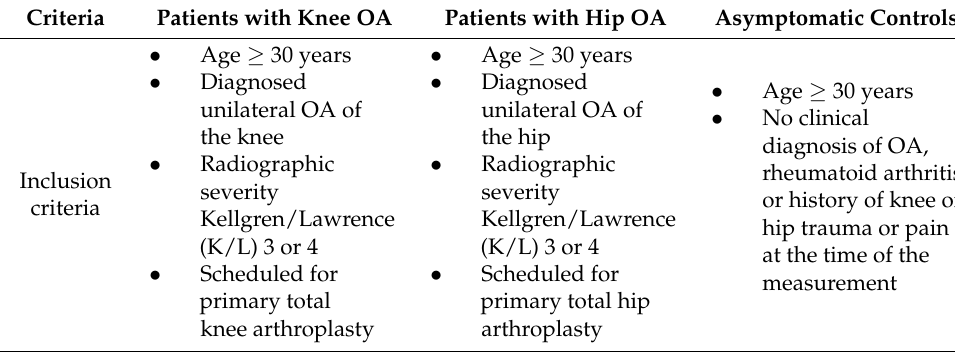
Table 2. Inclusion and exclusion criteria.